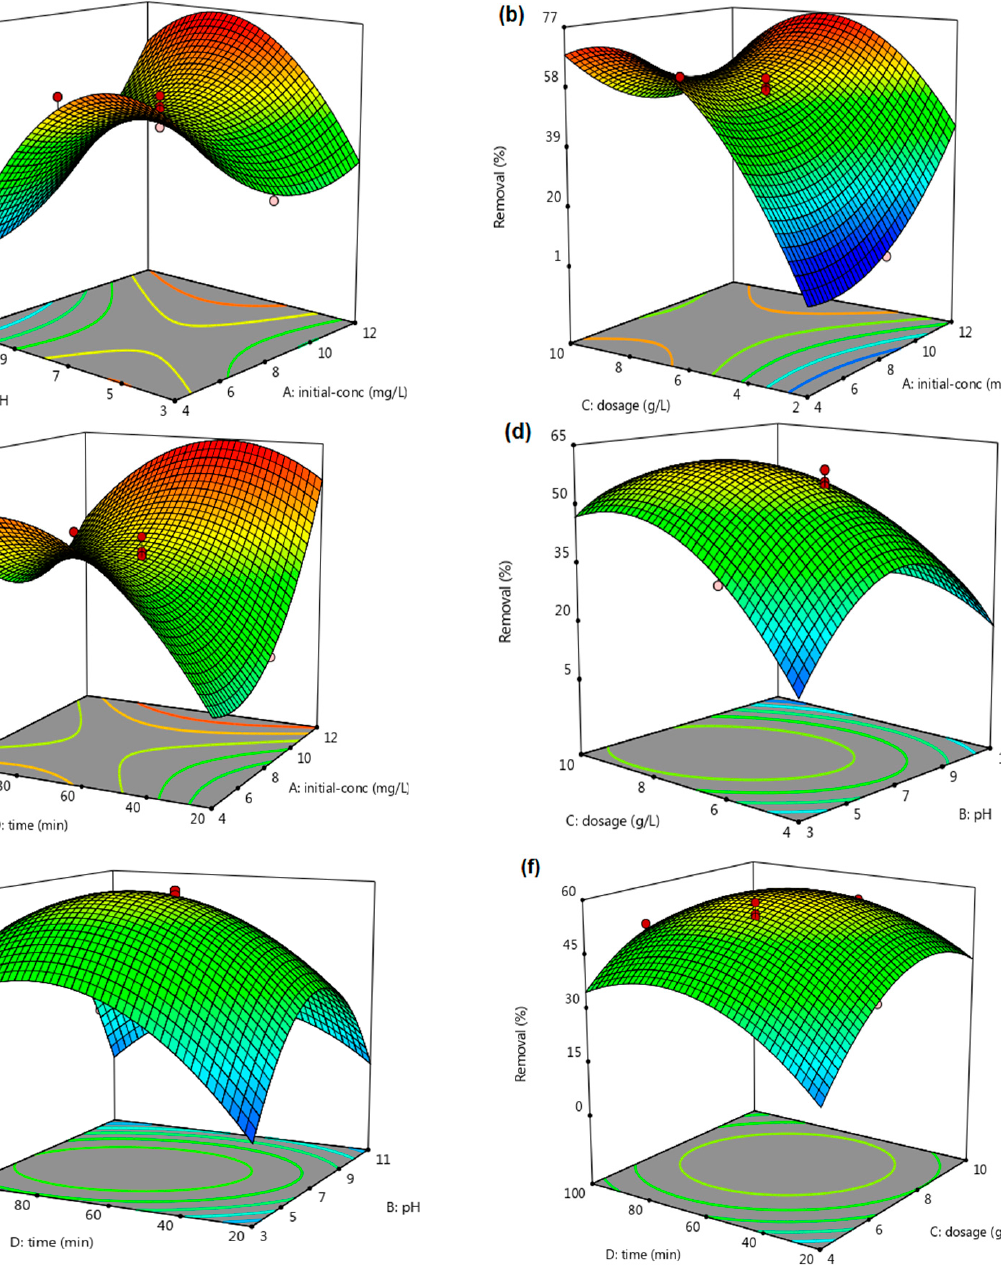
Figure 6. 3D plots of fluoride adsorption by the SC adsorbent showing the interaction effect of ( a ) F − concentration and pH, ( b ) F − concentration and dosage, ( c ) F − concentration and time, ( d ) pH and dosage, ( e ) pH and time, and ( f ) dosage and time.